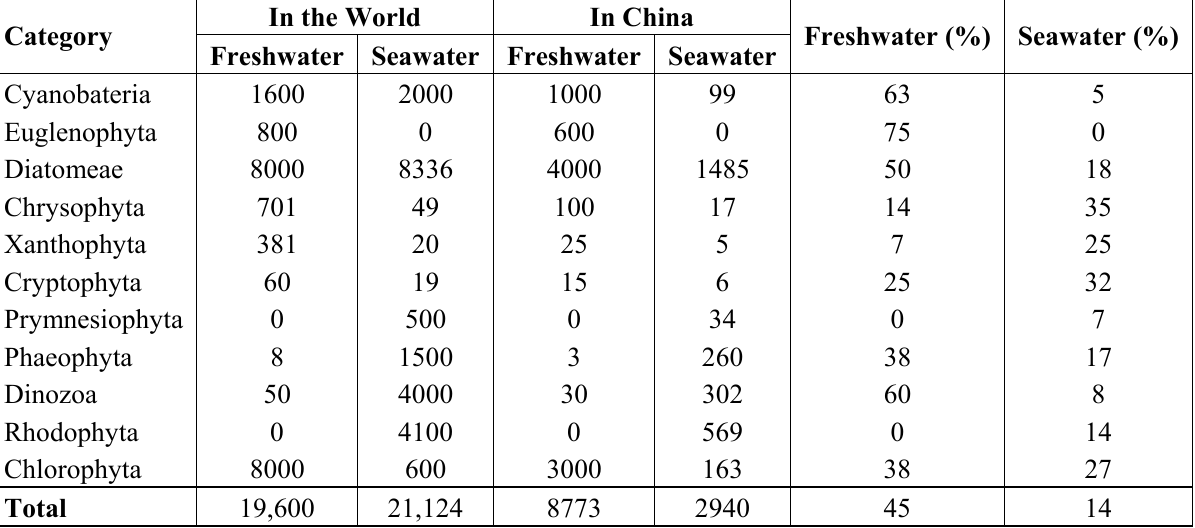
Table 1. Comparison of the species number of algae between china and the world [5,6].